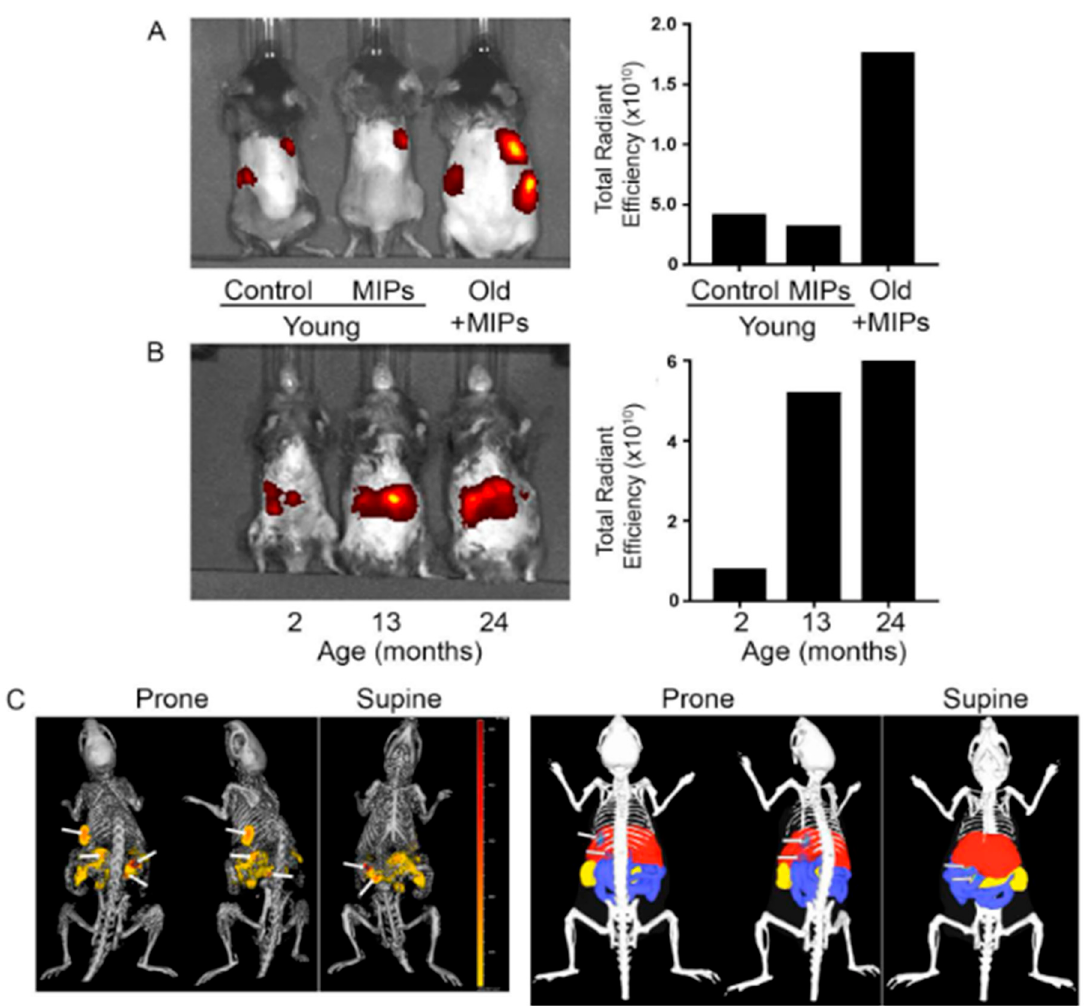
Figure 7. In vivo imaging of fluorescent B2M nanoMIPs. ( A ) Representative images of young (2 months) and old (15 months) mice injected intravenously with Alexa Fluor 647-tagged B2M MIPs. Control mice were injected only with vehicle. Animals were imaged in the prone position 2 h after injection. Total fluorescence signals were quantified and are shown in units of radiant efficiency. ( B ) Same as ( A ), with another group of mice of different ages, imaged in supine position. ( C ) 3D whole-body micro-CT (top) and fluorescence imaging tomography (FLIT, bottom) of the 15-month-old mouse in ( A ). Reproduced with permission [77] © 2021 The Royal Society of Chemistry .